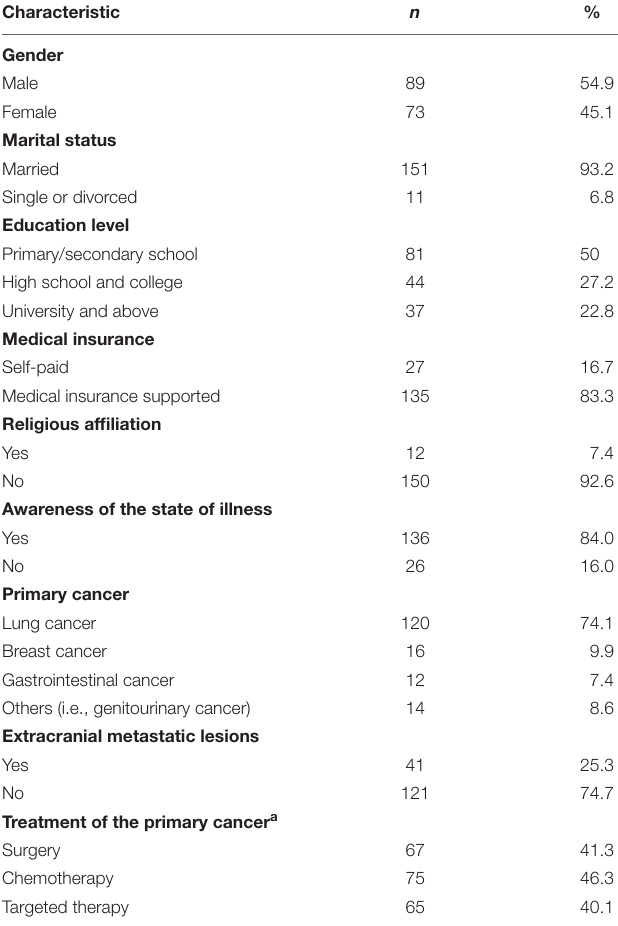
TABLE 1 | Sociodemographic and clinical characteristics of the patient sample ( n =